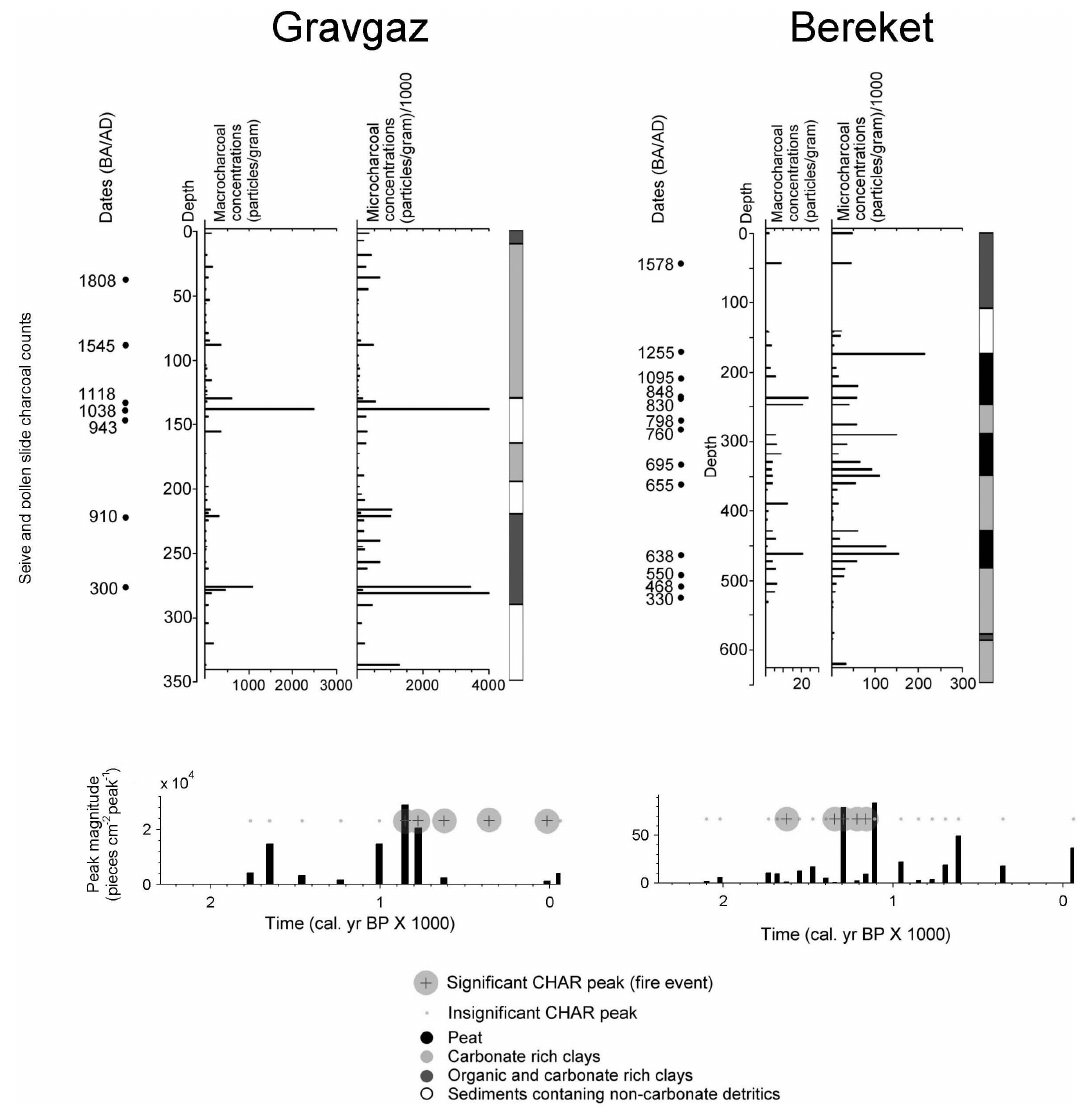
Fig. 6. Top: peak magnitude and fire frequency as determined by CharAnalysis. Bottom: micro- and macroconcentrations and lithology.